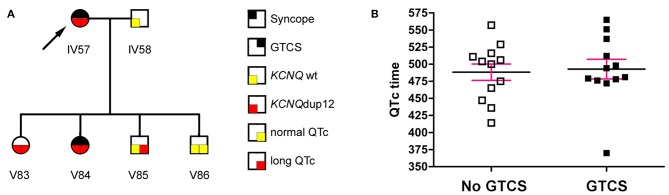
(A) The index patient (arrow) had a long-standing history of seizures. Diagnosis of LQT syndrome was established when her daughter V84 was diagnosed with a prolonged QT interval after two syncopes. (B) The QTc interval (mean ± SEM) was not significantly different between mutation carriers with or without generalized tonic-clonic seizures (GTCS) (P = 0.795, Mann Whitney test).